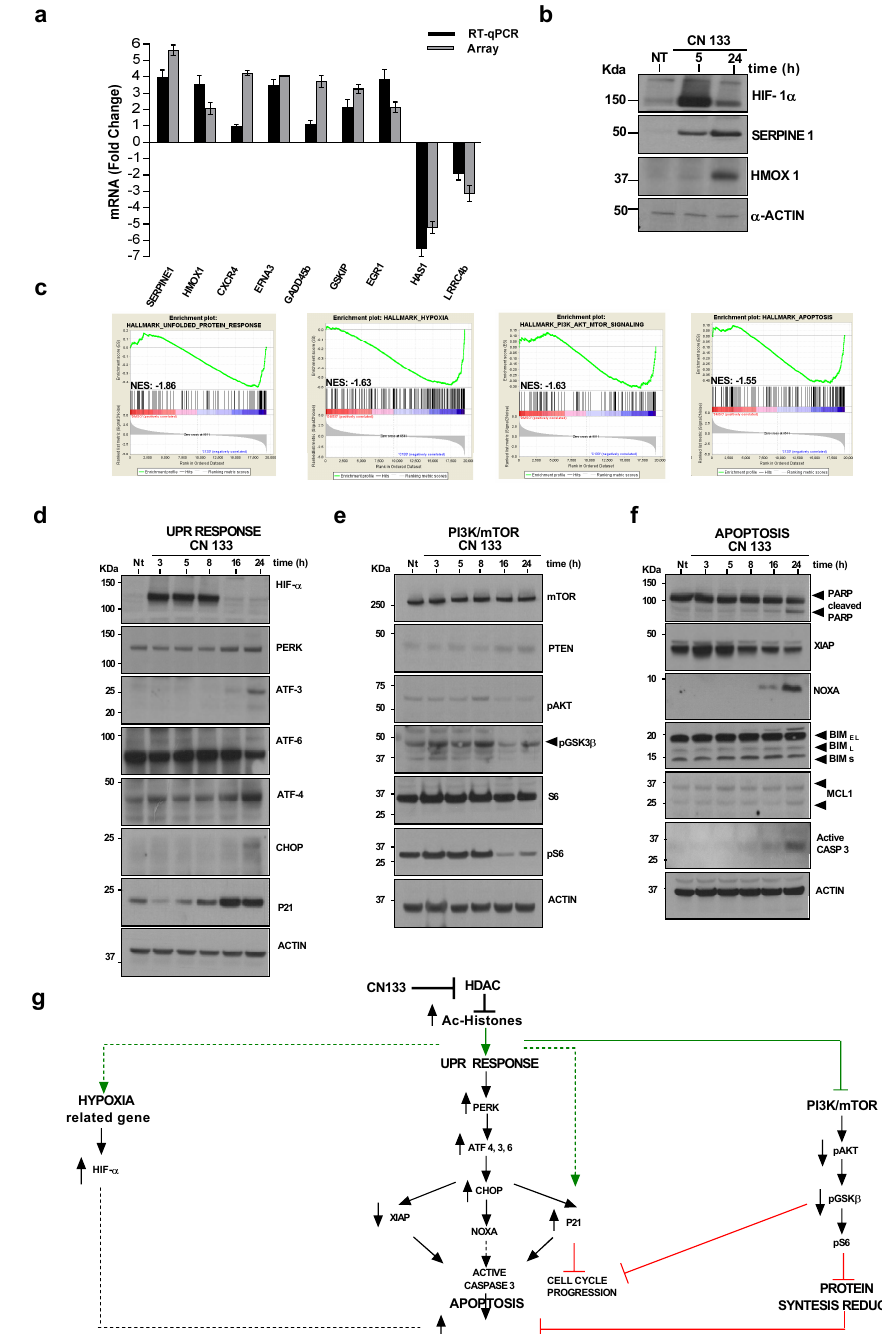
Figure 6. CN133 modulates several cancer-related pathways. Uncropped Blots are shown in Figure